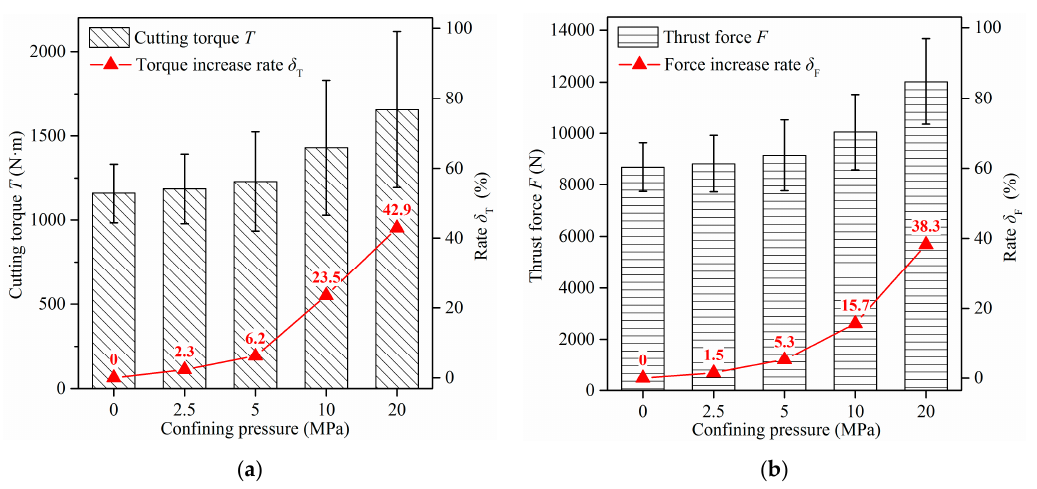
Figure 18. Effect of confining pressure on ( a ) cutting torque and ( b ) thrust force.